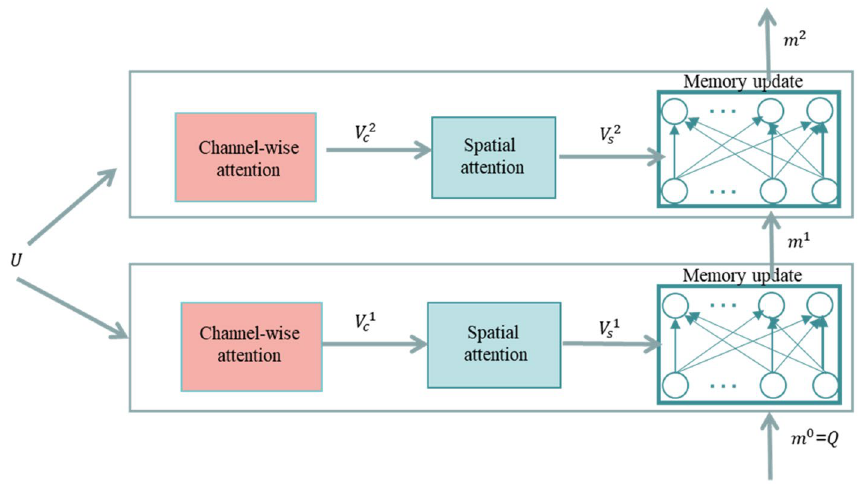
Figure 4. Schematic diagram of two iterations of episodic memory